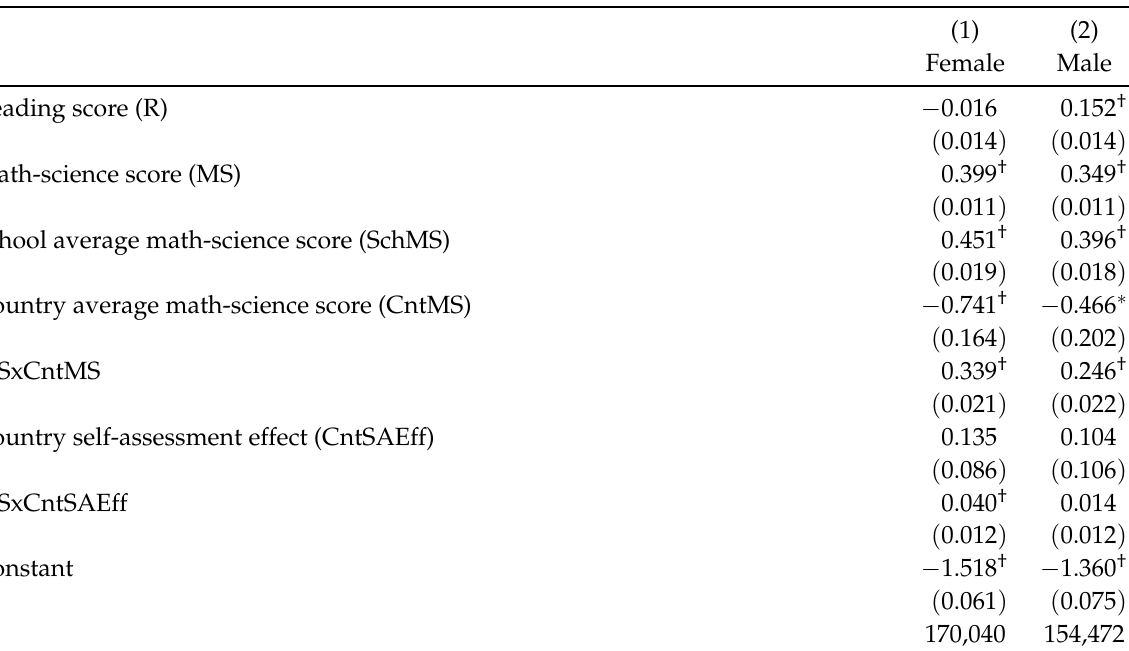
Table 3: Models for STEM Orientation Including Interaction Effects Between Gender, Individual Achievement, and National Math-Science Performance or Self-Assessment